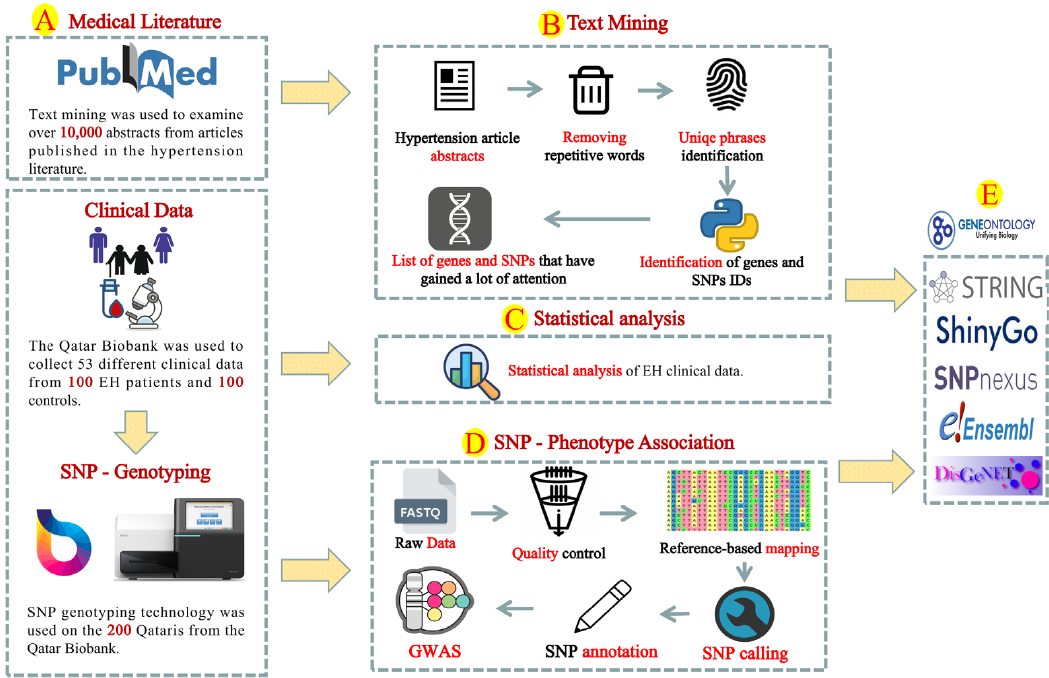
Figure 1. A flowchart representing the genetic resources and bioinformatics methods used in the present research. Thousands of hypertension-related articles were reviewed, as well as the SNP genotyping of 200 Qataris with high blood pressure ( A ) using text mining ( B ), statistical analysis ( C ), and GWAS ( D ). The text mining analysis included eliminating redundant words, recognizing unique phrases, detecting genes and SNP expressions, and categorizing these genes and SNPs based on their prevalence and redundancy ( B ). Fifty-three different clinical data of the studied patients were retrieved from QBB and used for statistical analysis ( C ). The SNP genotyping data were analyzed using a quality control method before being aligned/mapped to the human genome, where discovered SNPs were annotated and their association with high blood pressure was investigated using GWAS analysis ( D ). The details obtained from text mining and GWAS analysis was analyzed using gene ontology and enrichment analyses ( E